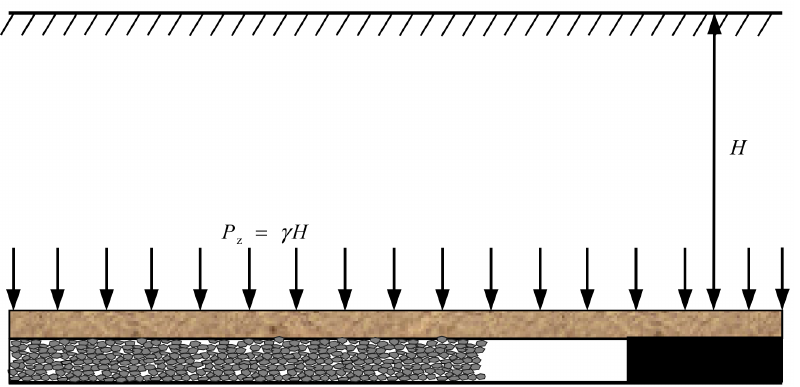
Figure 4. Model hypothesis diagram.